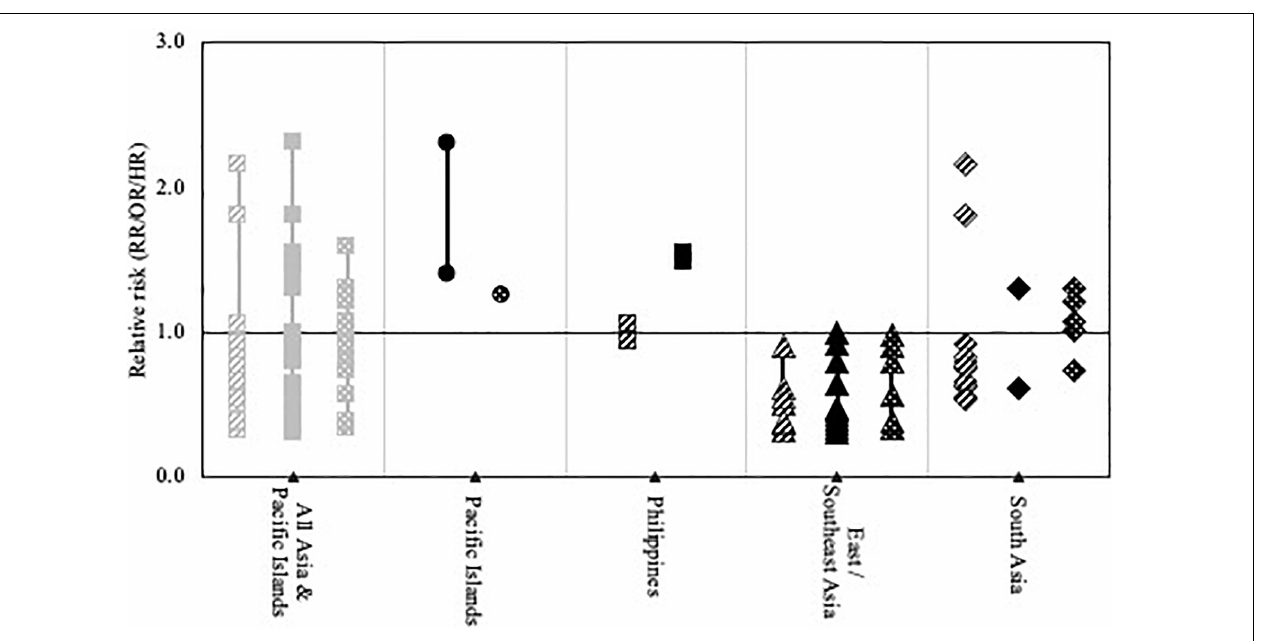
FIGURE 2 | Visual representation of point estimates for relative PE risk reported in the included studies among women of Asian and Pacific Islander origin compared to non-Hispanic White women. Asian or Pacific Islander women living in Europe; living in the US; living in South Africa; living in another predominantly White country. Study quality and precision of the estimates were not accounted for in the figure, and it should thus be interpreted as an overview of the available evidence, not as a formal statistical